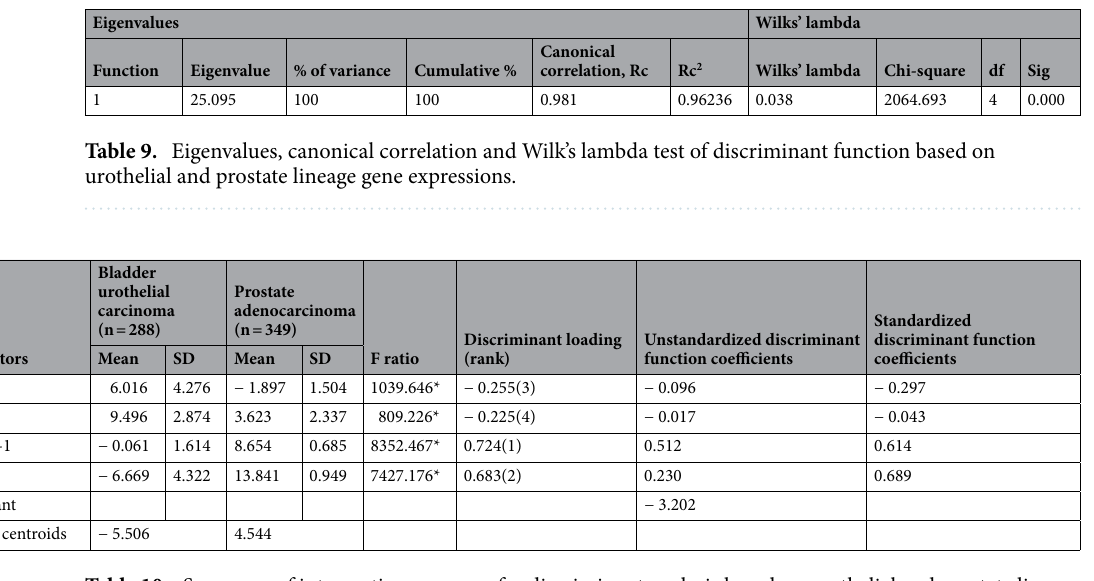
Table 10. Summary of interpretive measures for discriminant analysis based on urothelial and prostate lineage gene expressions. Discriminant function, D1 = − 0.096(UPK2) − 0.017(S100P) + 0.512(NKX3-1) + 0.230(KLK3) − 3.202. *p <